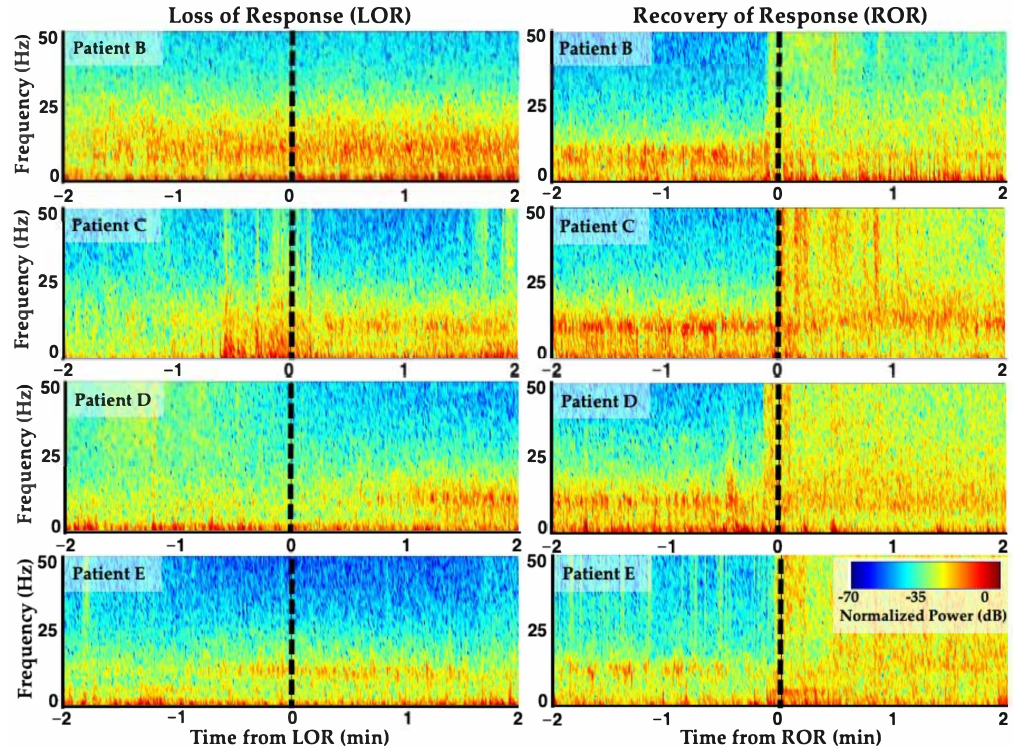
Figure 5. Individual variability in EEG response dynamics to propofol anesthesia. Spectrograms from four patients’ frontal EEGs surrounding loss of response (LOR) and recovery of response (ROR) with propofol anesthesia. LOR and ROR timepoints indicated with dashed lines. Decreases in high frequency activity, increases in low frequency and alpha band activity occur with LOR, and vice versa for ROR. However, individual EEG response dynamics around these time points differ between individuals. Reproduced with permission from Reference